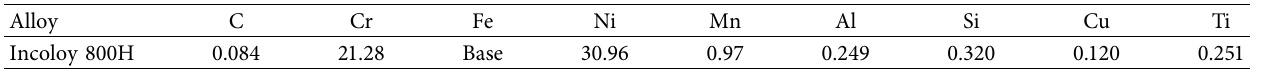
Figure 1: (a) Te schematic drawing of the system for high-temperature corrosion under impure helium and (b) the actual picture of the experimental facilities: (1) pure gas cylinder, (2) injection equipment for pure gas consisting of multiple mass fow controllers, (3) vacuum pump, (4) high-pressure gasholder, (5) mass fow controllers, (6) high-temperature furnace, (7) gas chromatography, and (8) water analyzer. Table 1: Composition of the Incoloy 800H alloy before the test (wt.%).